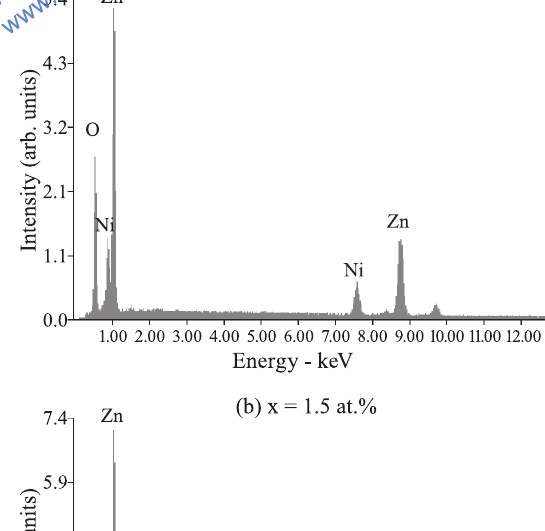
Table 1 The atomic content of the different elements of